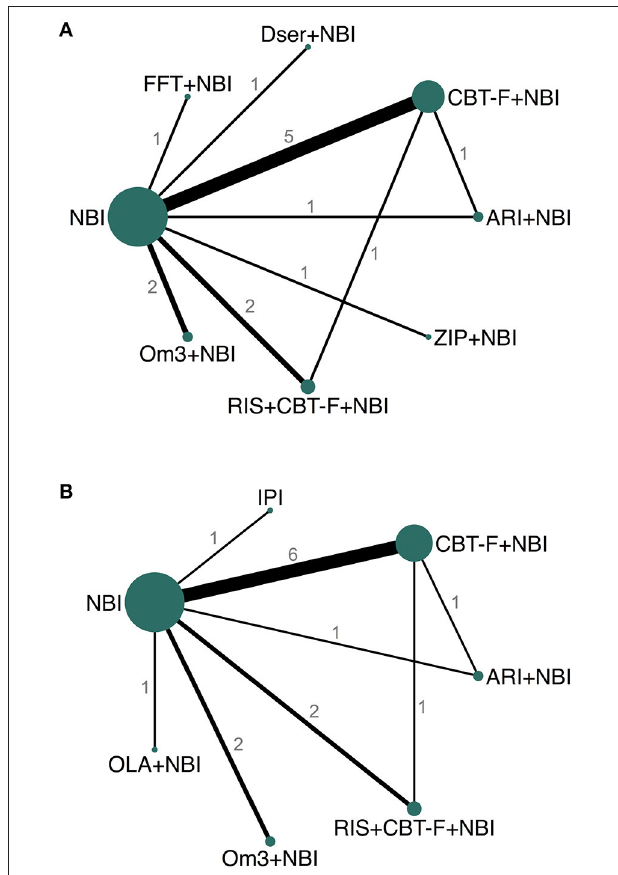
FIGURE 3 | Network plots of direct comparisons at 6 (A) and 12 (B) months. The width of the lines is proportional to the number of trials comparing each pair of treatments and the size of each node is proportional to the number of studies testing the specific treatment. Numbers represent the number of studies contributing data to each comparison. ARI, aripiprazole; NBI, needs-based interventions (including placebo); CBT-F, cognitive behavioral therapy (French and Morrison protocol); Dser, D-serine; FFT, family-focused therapy; Om3, omega-3 fatty acids; RIS, risperidone; ZIP, ziprasidone; IPI, integrated psychological interventions; OLA,